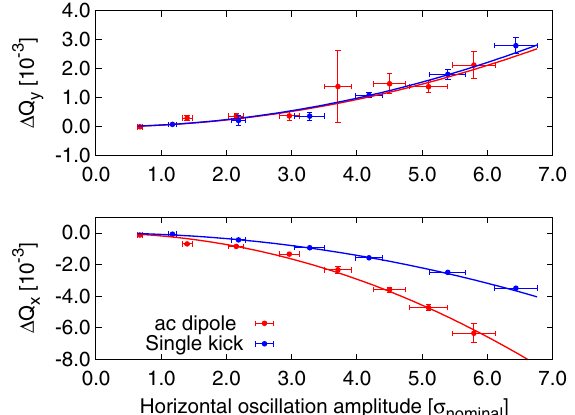
FIG. 7. On the top the ratio of the amplitudes of the drive tune and natural tune spectral lines in the horizontal and vertical plane is shown. Each plane is treated separately. On the bottom plot the oscillation amplitudes in both planes are shown as a function of the horizontal oscillation amplitude. This data set was acquired at top energy.